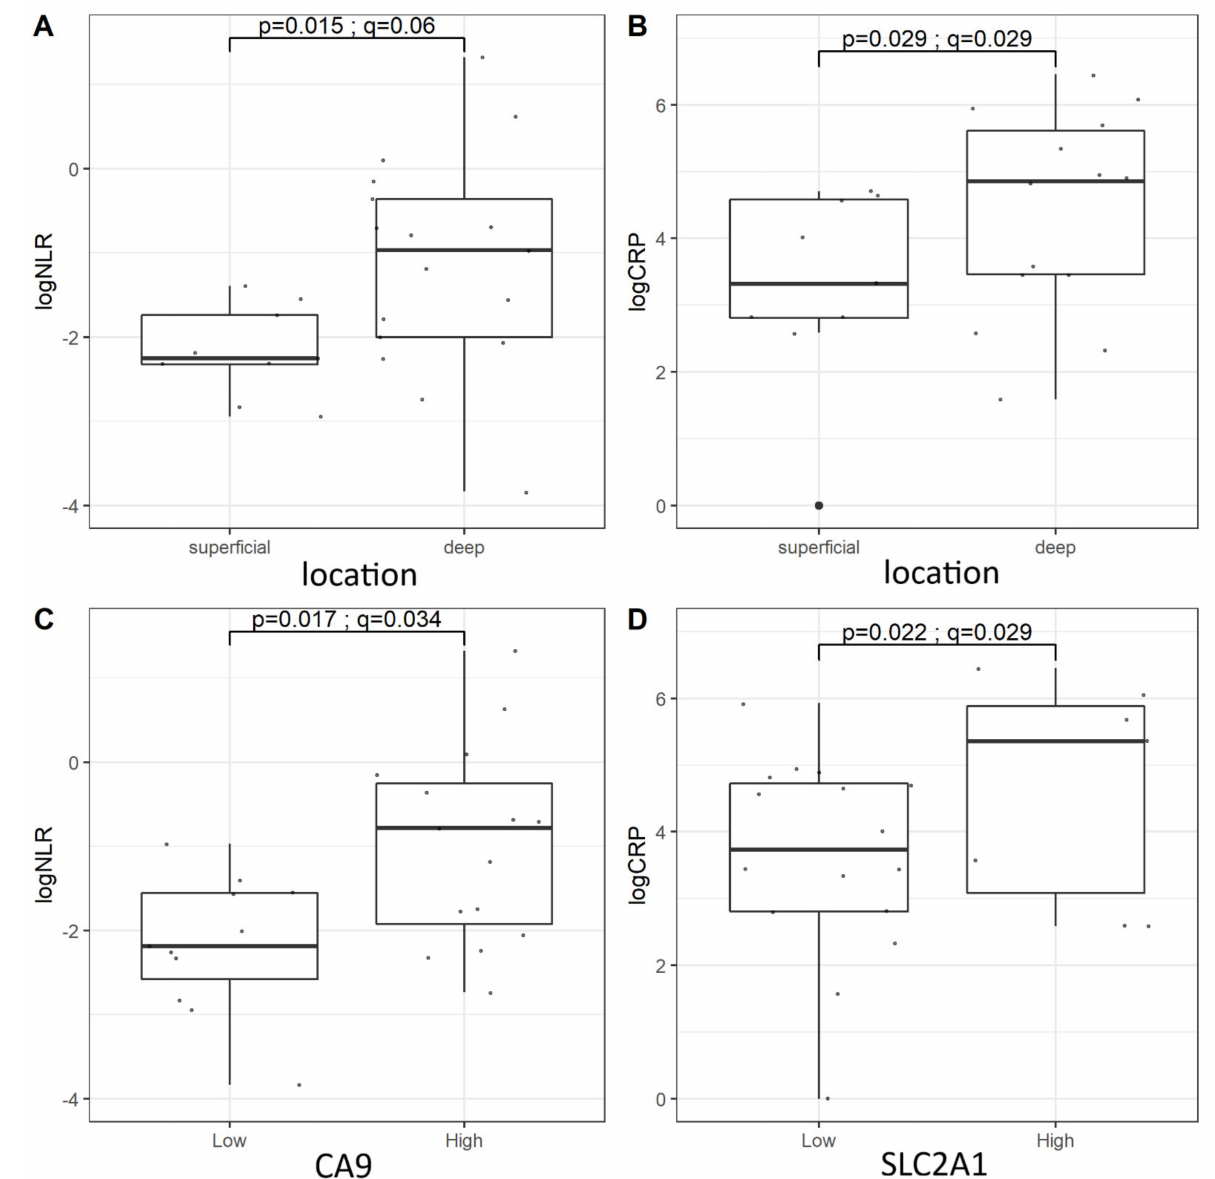
Figure 8. The associations between age-adjusted NLR and CRP levels and tumor location ( A , B ); and hypoxic markers (CA9, SLC2A1) expressions ( C , D ). Abbreviations: NLR—neutrophil-to-lymphocyte ratio, CRP—C-reactive protein, CA9—carbonic anhydrase 9, SLC2A1—solute carrier family 2 member